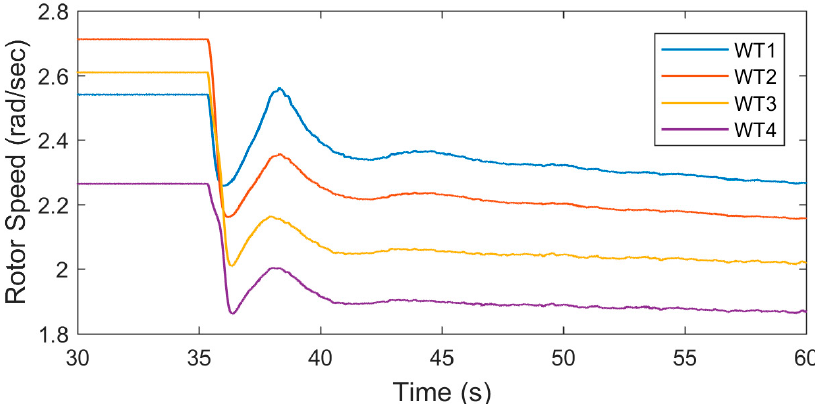
Energies 2019 , 12 , x FOR PEER REVIEW